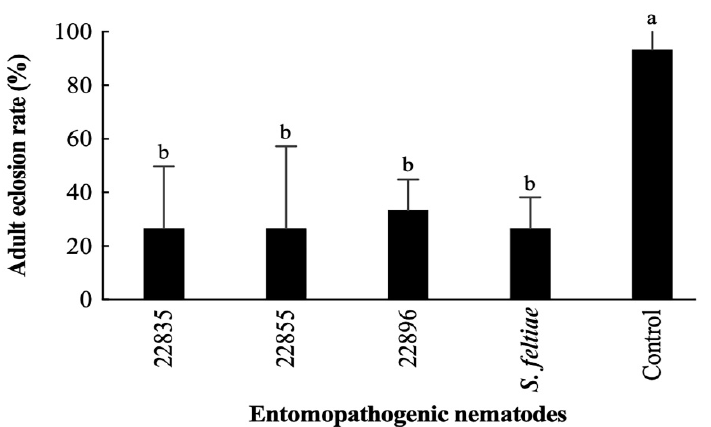
Figure 6 . Adult eclosion rate of Spodoptera frugiperda pupae by entomopathogenic nematodes. Pupae (five pupae per Petri dish) of S. frugiperda were treated with EPNs (1200 IJs) for five days. Bars with different letters represent significant differences between treatments by Tukey’s test ( p < 0.05). S.